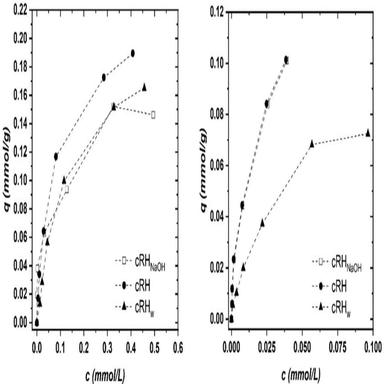
Copper (left) and lead (right) ions adsorption isotherms of cRH, cRHw, and cRHNaOH. (Mass of adsorbent = 20 mg, volume of aqueous model solution = 10 mL, metal ion initial concentration between 0 and 50 mg/L, equilibrium pH between 6 and 7, T = 20◦C). The ions concentration is affected by an error lower than 4 % while that of the adsorption capacity is lower than 6 %. Lines are guides for the eyes.